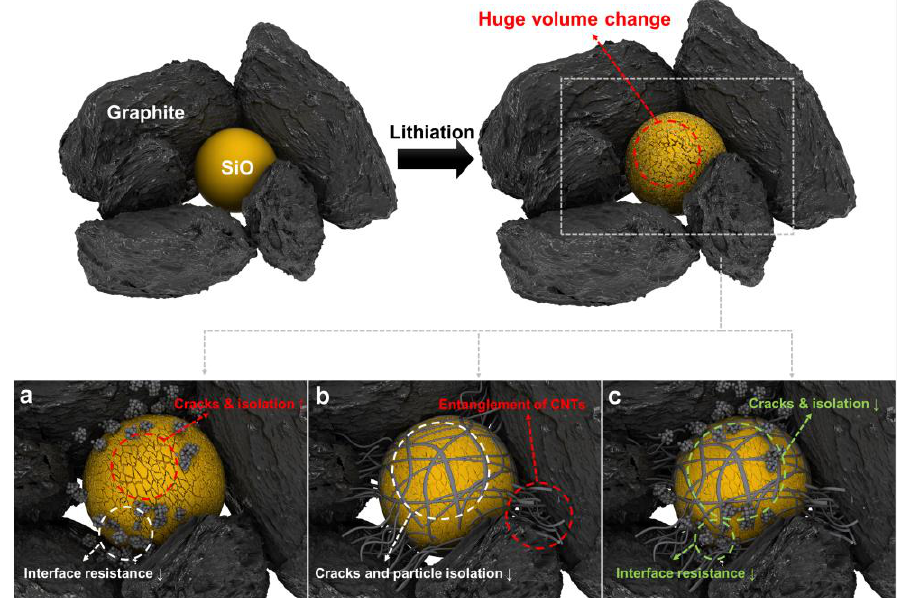
Figure 1. Schematic illustration of an electrode using ( a ) CB, ( b ) SWCNTs, and ( c ) hybrid